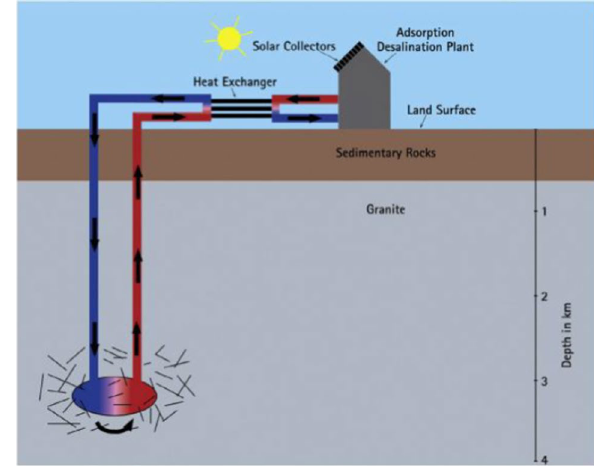
Fig. 38 The combined system consisted of solar and geothermal ener- gies for freshwater production (Missimer et al.